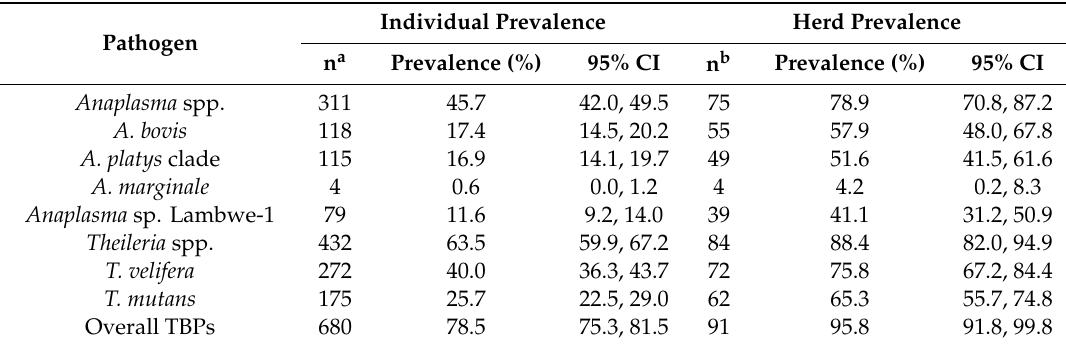
Table2. Individualanimal-andherd-levelapparentprevalencesofTBPsincattleatthewildlife–livestock interface of Lambwe Valley, western Kenya, 2018 /